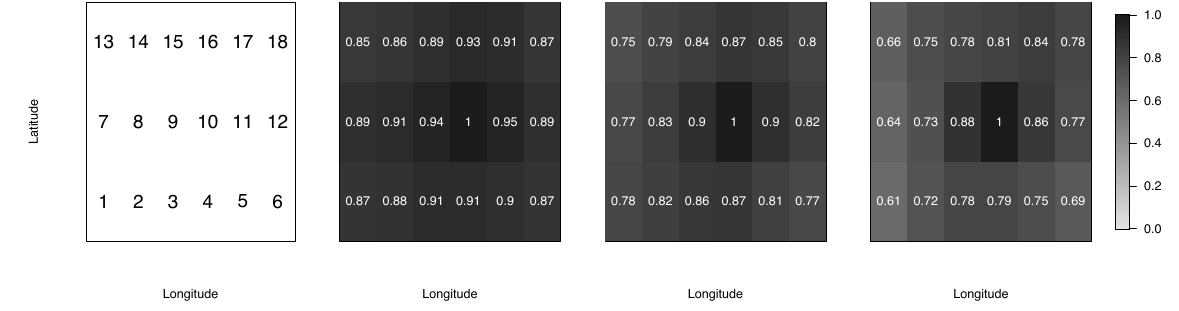
Figure 3. Leftmost panel: matrix with the number of the station is printed; then, from left to right, conditional probabilities of occurrence of regime i = 1 , 2 , 3 at all sites conditional on the simultaneous occurrence of the same regime at site 10; in each pixel, the value of the conditional probability is